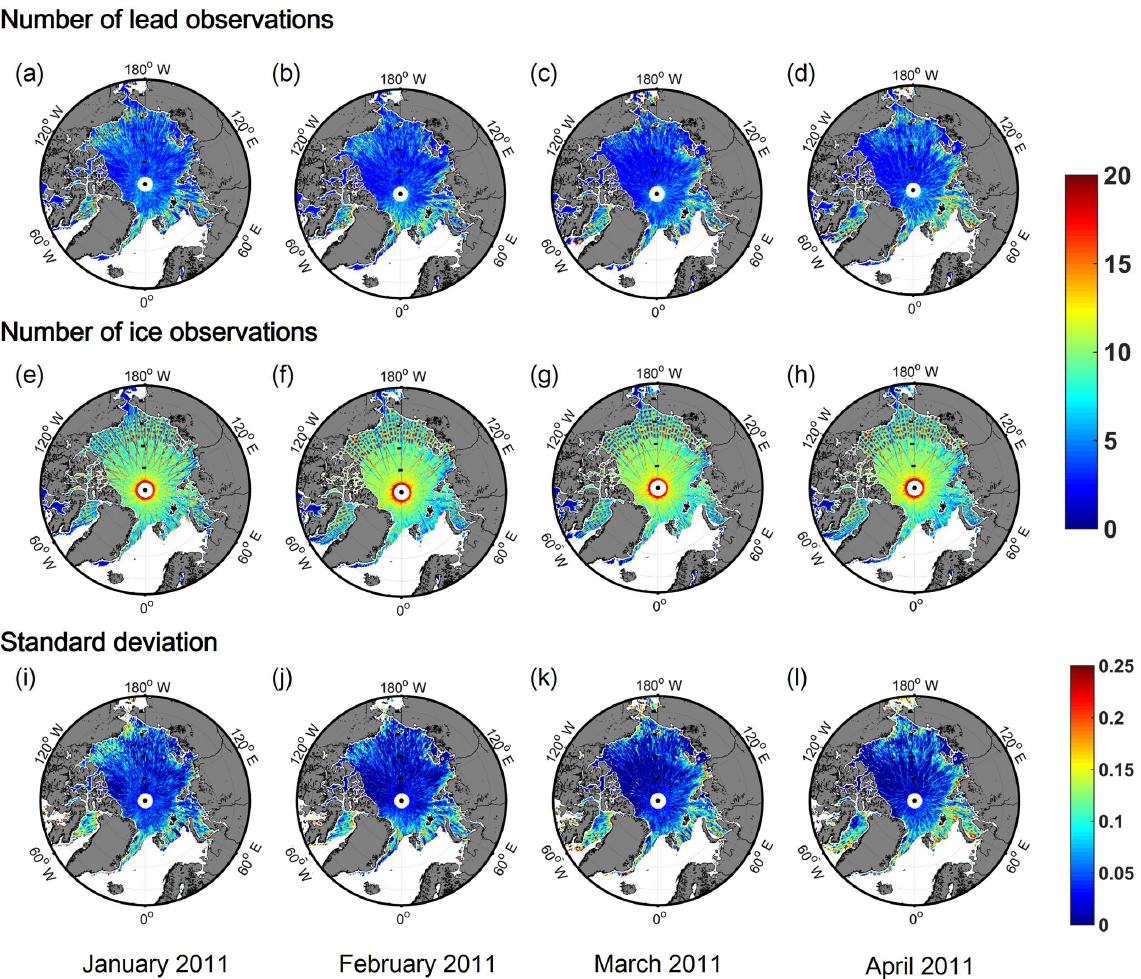
Figure 9. (a–d) The number of lead observations, (e–h) the number of ice observations, and (i–l) the standard deviation of the results based on the sensitivity analysis of lead fraction from January to April